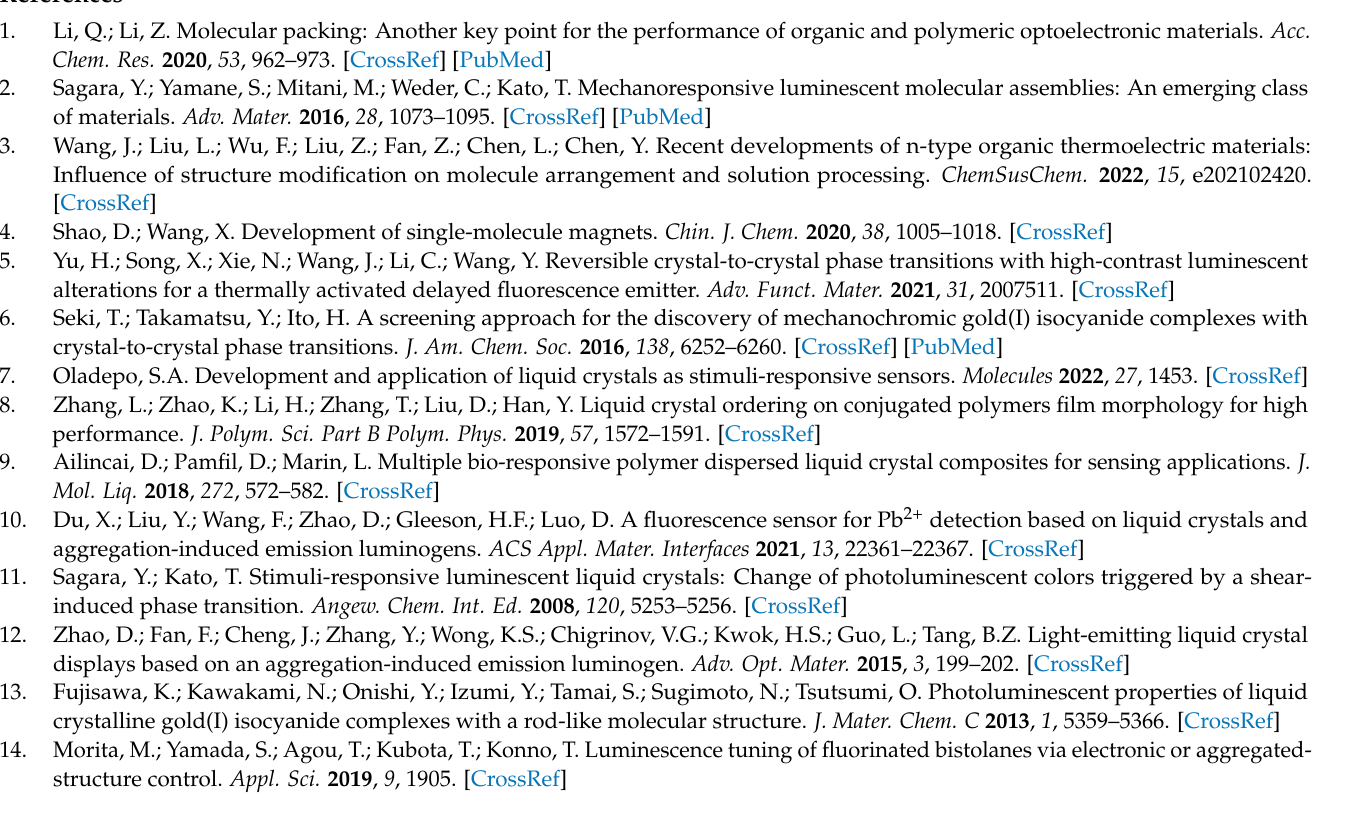
PL spectra in Cry phase; Figure S21: PXRD patterns measured at 25 ◦ C; Figure S22: Excitation and PL spectra in SmA phase; Figures S23–S26: Optimized structures and molecular orbital distributions; Figure S27: Possible aggregated structures of 2d in the mesophase; Table S1: Phase transition behavior; Tables S2–S5: Cartesian